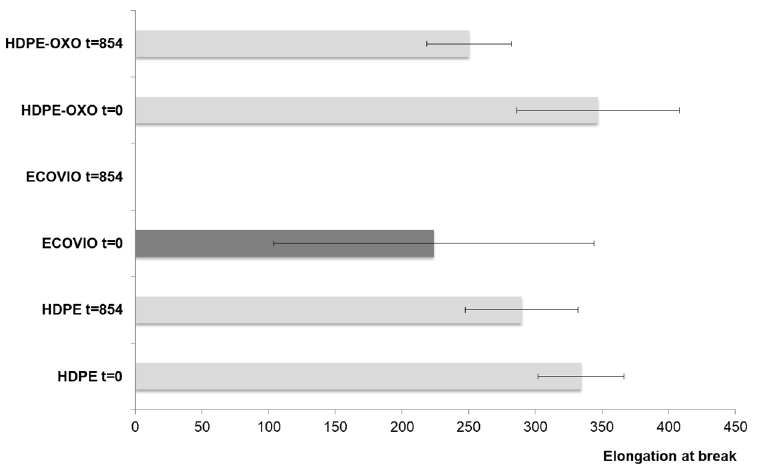
Figure 2. Elongation at break of plastic films before and after degradation. Error bars show the standard deviations of ten samples.